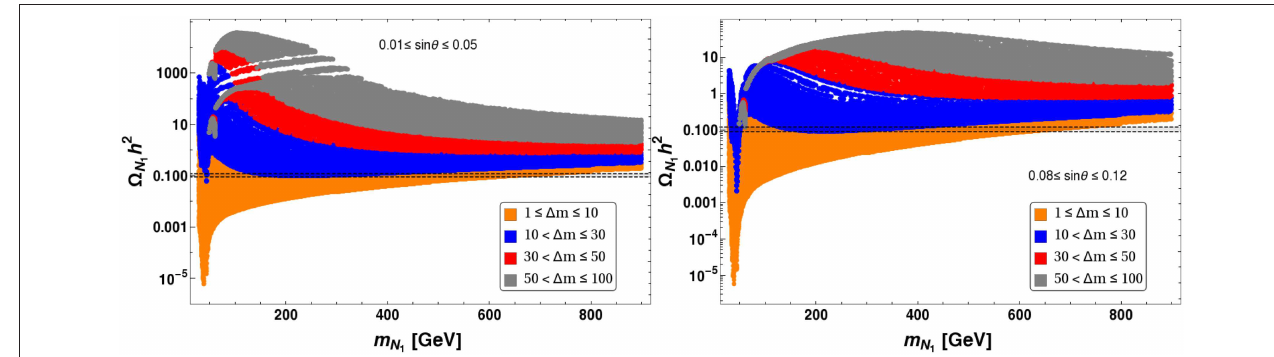
sin θ 0.12 (right panel). The ≤ ≤ 50 (Red) and ≤